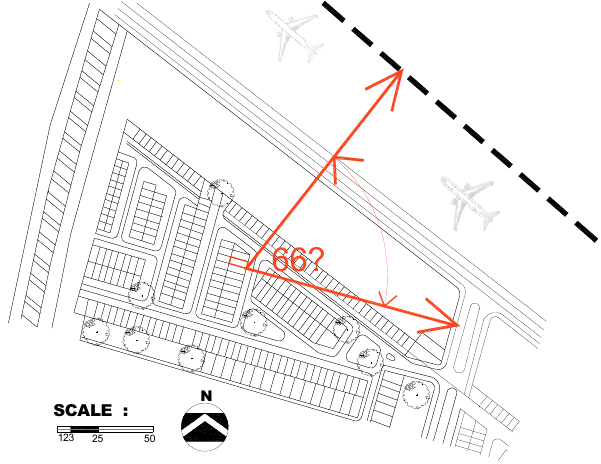
Figure 16. The 66 ◦ oriented building block toward Figure 16. The 66° oriented building block toward runway.